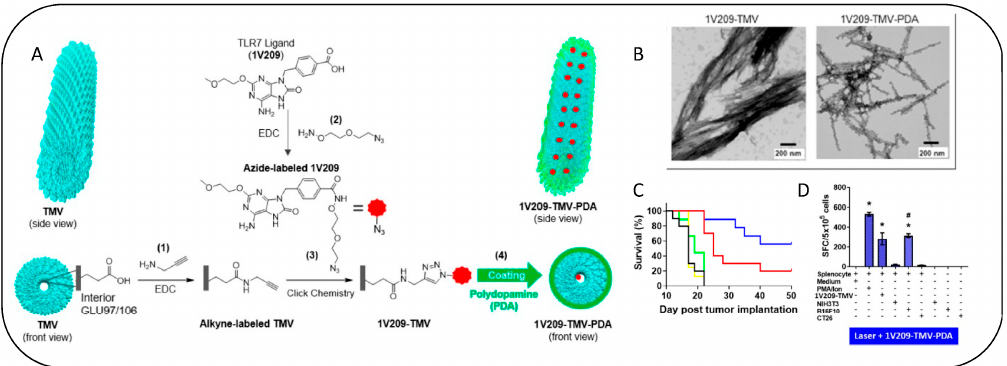
Figure 9. Schematic depiction of the bioconjugation and coating reactions on TMV: ( A ) alkyne la- belling of TMV through amidation of the interior glutamate residues of TMV with propargyl amine;